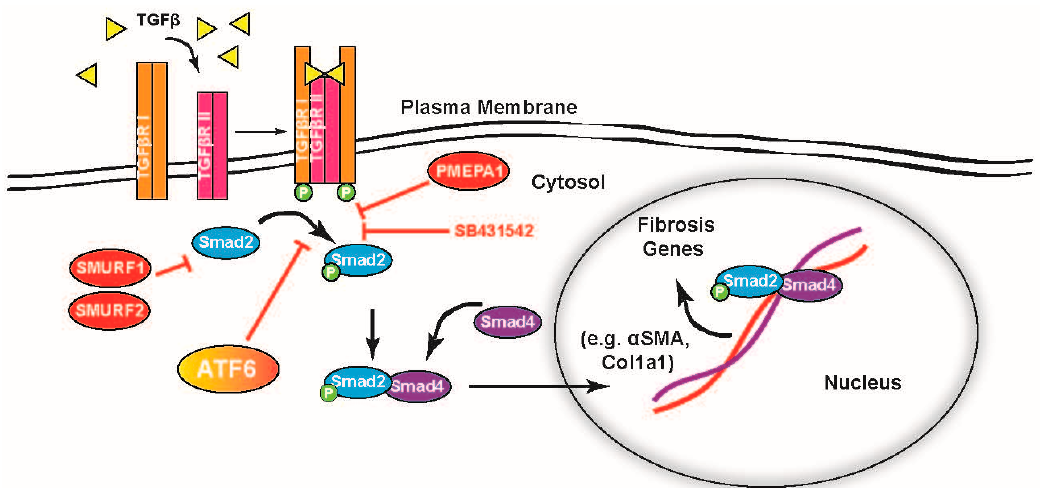
Figure 8. Representation of ATF6 acting on the TGF β –Smad pathway for induction of fibrosis genes. TGF β is a ligand for TGF β receptor II, which upon binding forms a receptor complex with TGF β receptor I, activating their kinase function. The TGF β receptor complex phosphorylates receptor-Smads 2 and 3, which then complex with co-Smad 4 and move to the nucleus where they activate fibrosis genes (black arrows). These data suggest ATF6 activity inhibits the phosphorylation of the receptor-Smads at or before the level of the TGF β chemical inhibitor SB431542 (red “T” arrows).